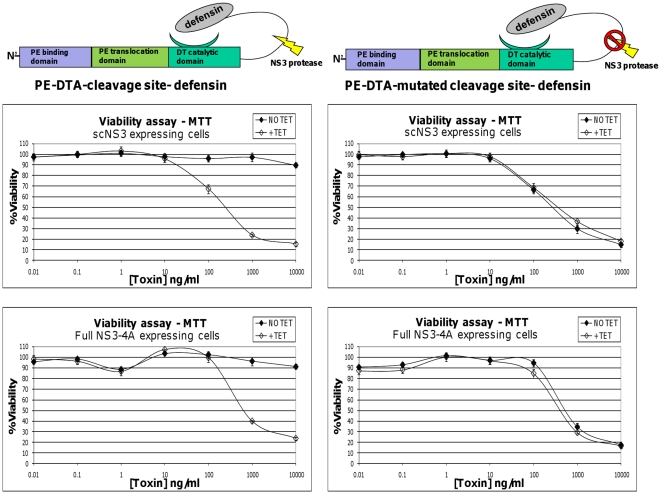
Viability assay of NS3 expressing cells treated with DTA based zymoxins.T-Rex cells inducibly expressing scNS3 or full NS3-4A were seeded in 96-well plates (4×104 cells per well). After 9 hours, cells were treated with 1µg/ml of tetracycline (+TET) or left untreated (NO TET). 2 hours later, cells were incubated for 72 hours with serial dilutions of the toxins “PE-DTA-cleavage site-defensin” or “PE-DTA-mutated cleavage site- defensin” (presence of tetracycline was kept in the growth media of induced cells). The relative fraction of viable cells was determined using an enzymatic MTT assay. A representative graph of three independent experiments is shown. Each point represents the mean ±SD of a set of data determined in triplicates.